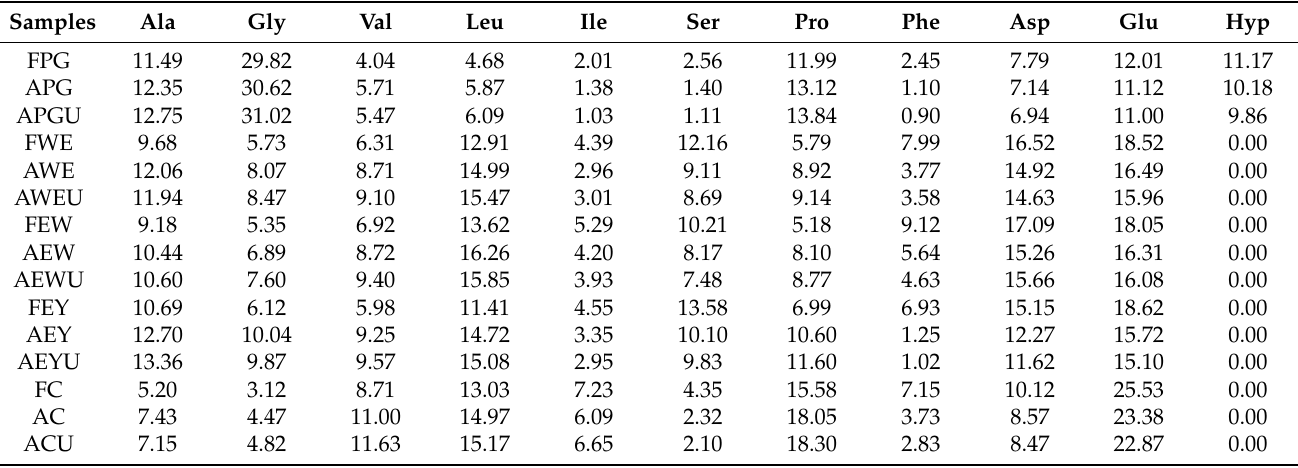
Table 1. The average contents of the 11 amino acids in the five fresh and aged